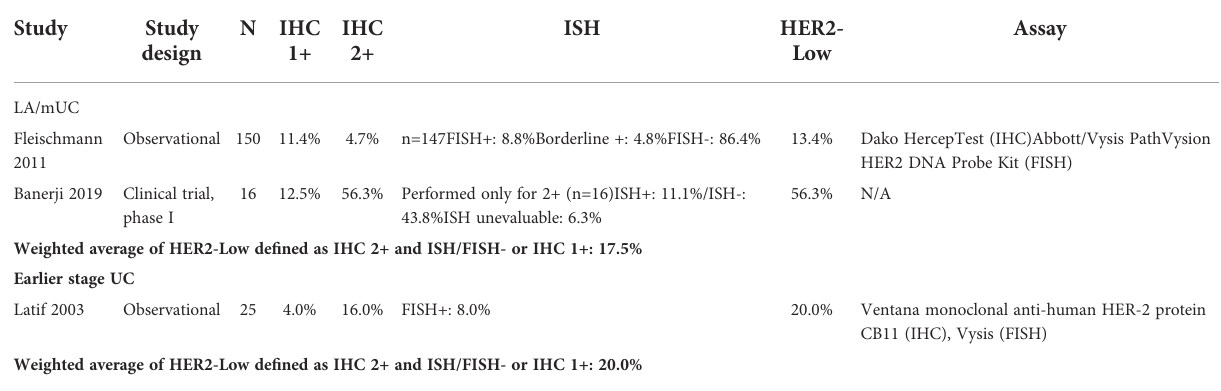
TABLE 2 Overview of